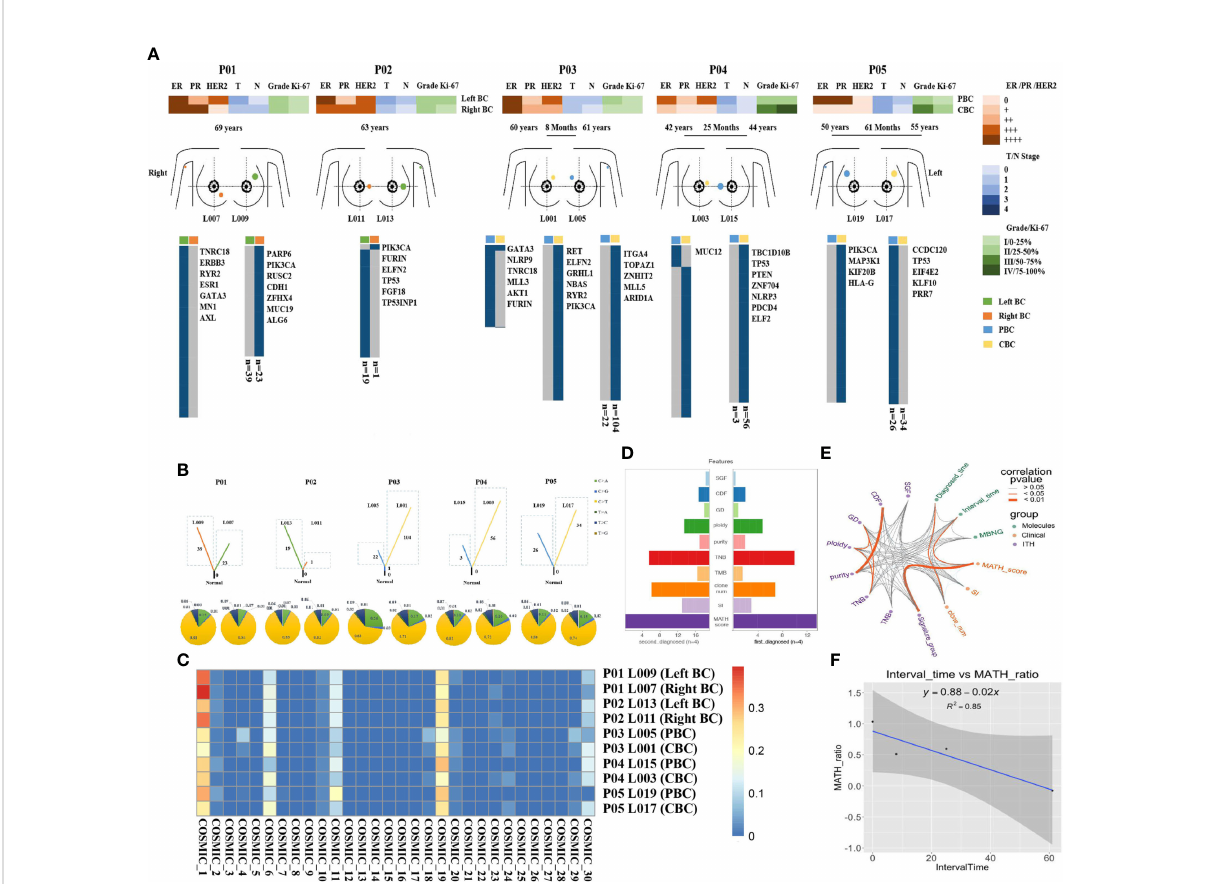
FIGURE 2 Heterogeneity of somatic mutations and clonal evolution in BBC. (A) Heat maps show the clinical characters and individual somatic mutations of fi ve BBC patients with different interval time (rang from less than 6 months to 61 months) in right breast (orange) and left breast (green) of SBBC (P01 and P02), or PBC (blue) and CBC (yellow) of MBBC. The presence (blue) or absence (gray) of each mutation is indicated for every tumor region. Clonal evolution of 10 pathological specimens after operation (L001 to L019) from different spatial regions. (B) Fraction of early mutations (trunk) and late mutations (branch) accounted for by each of the six mutation types in all samples. Driver mutations occurring in an APOBEC signature (C > T and C > G mutations) are highlighted with blue and yellow box. (C) Heat maps show the common mutational signatures via COSMIC. (D) The total importance for each feature group. SGF, sub-clonal genome fraction; CDF, cancer DNA fraction; GD, genome doublings; TNB, tumor neoantigen burden; TMB, tumor mutational burden; clone_num, clone numbers; SI, Shannon index. (E) The correlation and prognosis importance for 14features, including clinical (green points), molecular (purple points) characters, and ITH (orange points) was shown by wires. Dark orange wires meant the relevance of each point had statistically signi fi cant ( p< 0.05) and gray wires meant insigni fi cance ( p > 0.05). (F) The relationship of the interval time and MATH-score-ratio was described by regression equation, y = 0.88 –